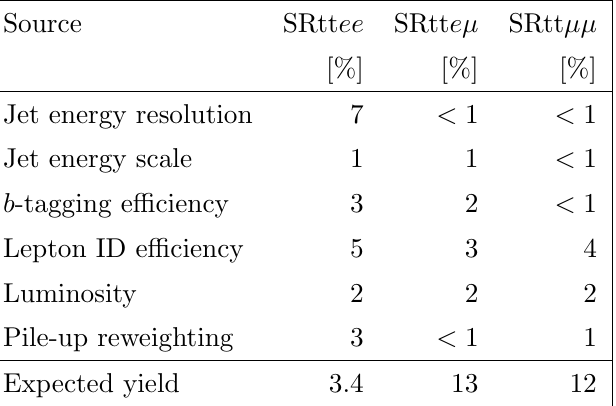
Table 11 . Uncertainty of the event yields in the signal regions for a representative signal of the same-sign top-quark pair production search (exclusive tt production, m V = 2 TeV normalised to 100 fb) due to the leading sources of experimental systematic uncertainty. In all three channels, the uncertainty due to jet energy resolution is compatible with the statistical uncertainty of the simulated